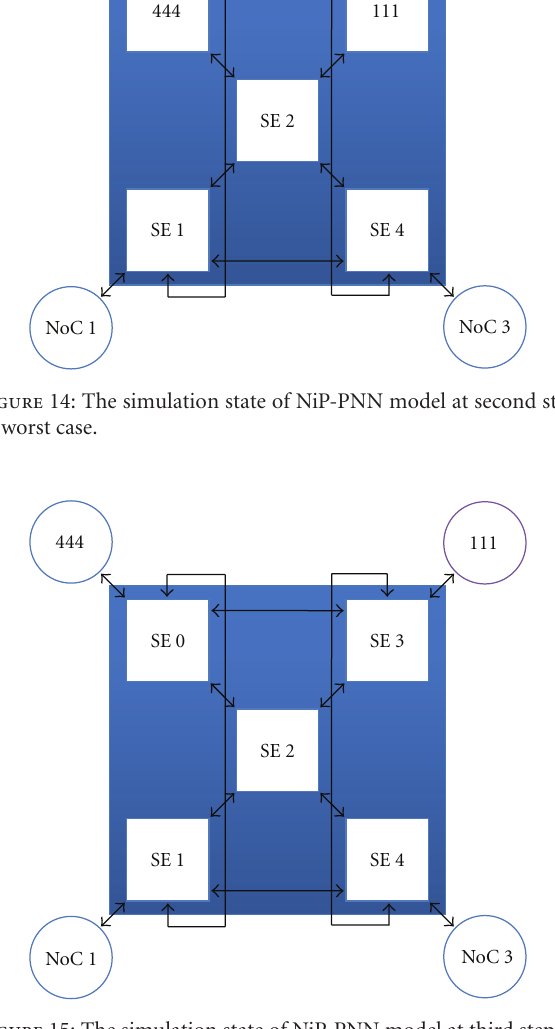
Figure 15: The simulation state of NiP-PNN model at third step of worst case.